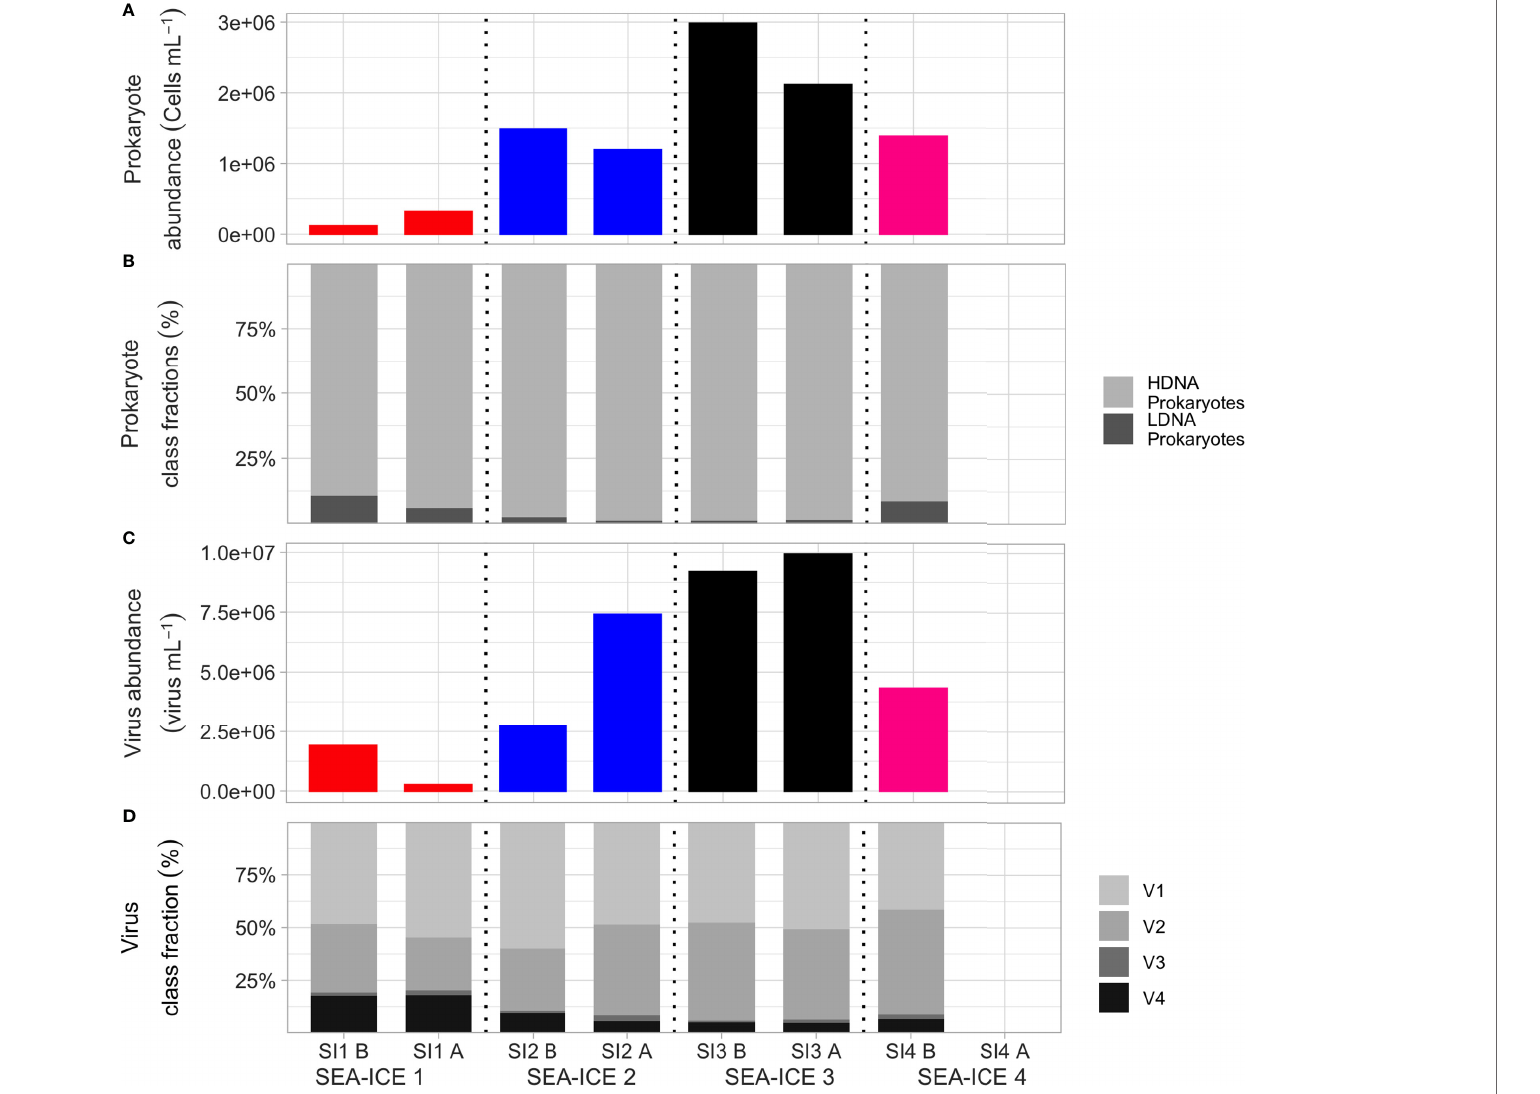
FIGURE 2 | Changes of prokaryote- and virus-related parameters measured in the four sea ice experiments before and after the aerosol generation period. For each experiment the fi rst bar corresponds to the values estimated before ( “ B ” ) bubbling; the second bar shows the values after ( “ A ” ) bubbling. From top to bottom, the graphs show (A) prokaryote concentrations; (B) proportion of HDNA and LDNA bacteria; (C) concentrations of viral particles; (D) distribution (as %) of the different types of virus